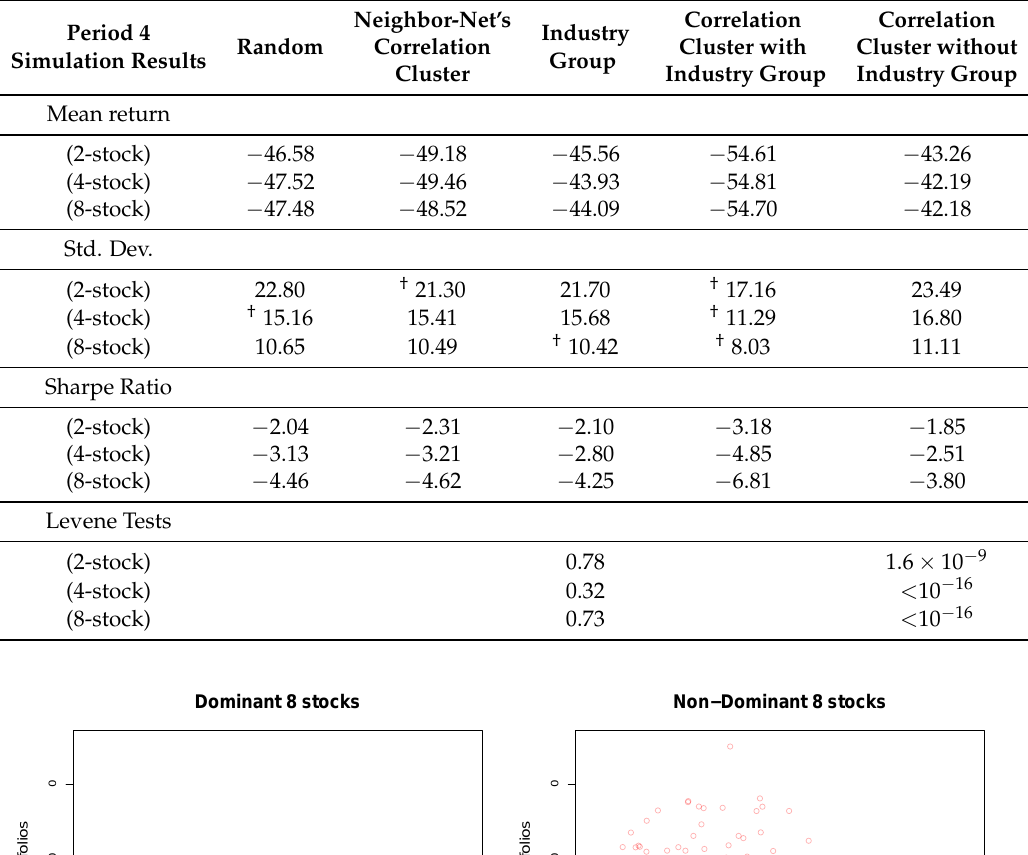
Table 4. Period 4 portfolio performances with standard deviation for three different portfolio sizes. The selection method with the lowest standard deviation is marked with an dagger ( † ).